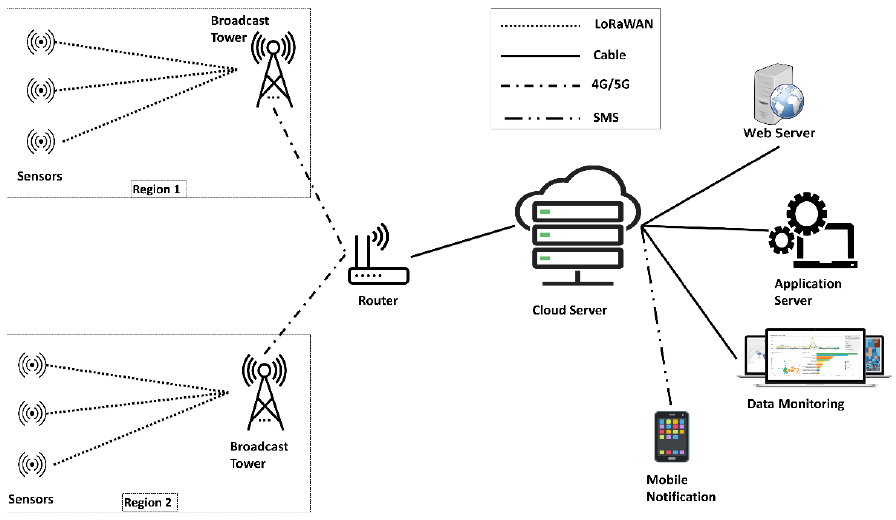
Figure 2. The suggested